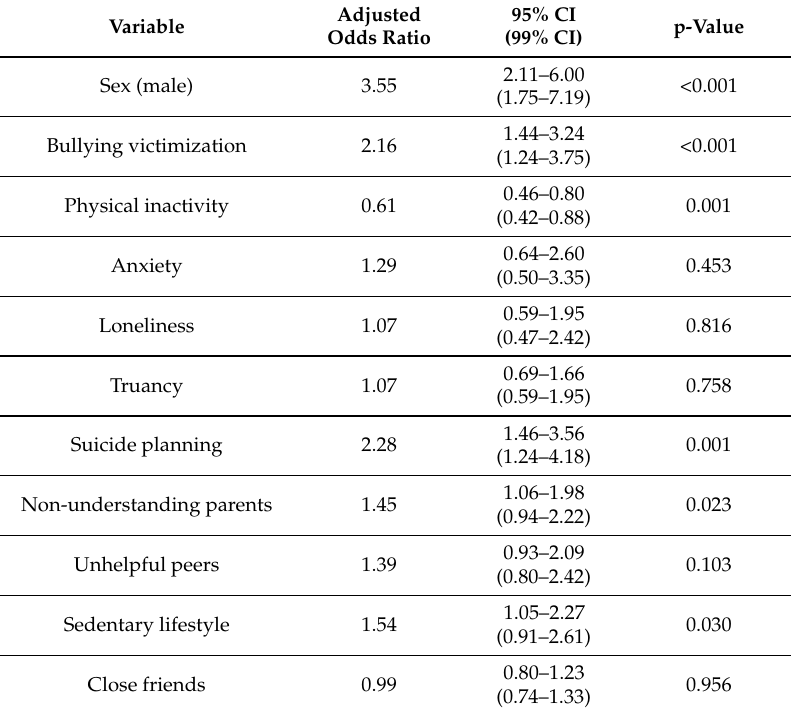
Table 4. Outcomes of the multivariate analysis of variables associated with physical fighting attempts among school-attending adolescents in El Salvador, GSHS